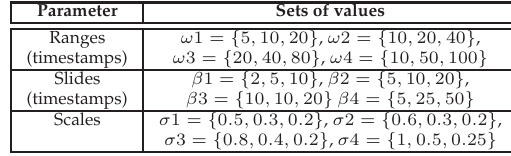
Table 1: Experimentation parameters. Table 2: Custom 3-level window